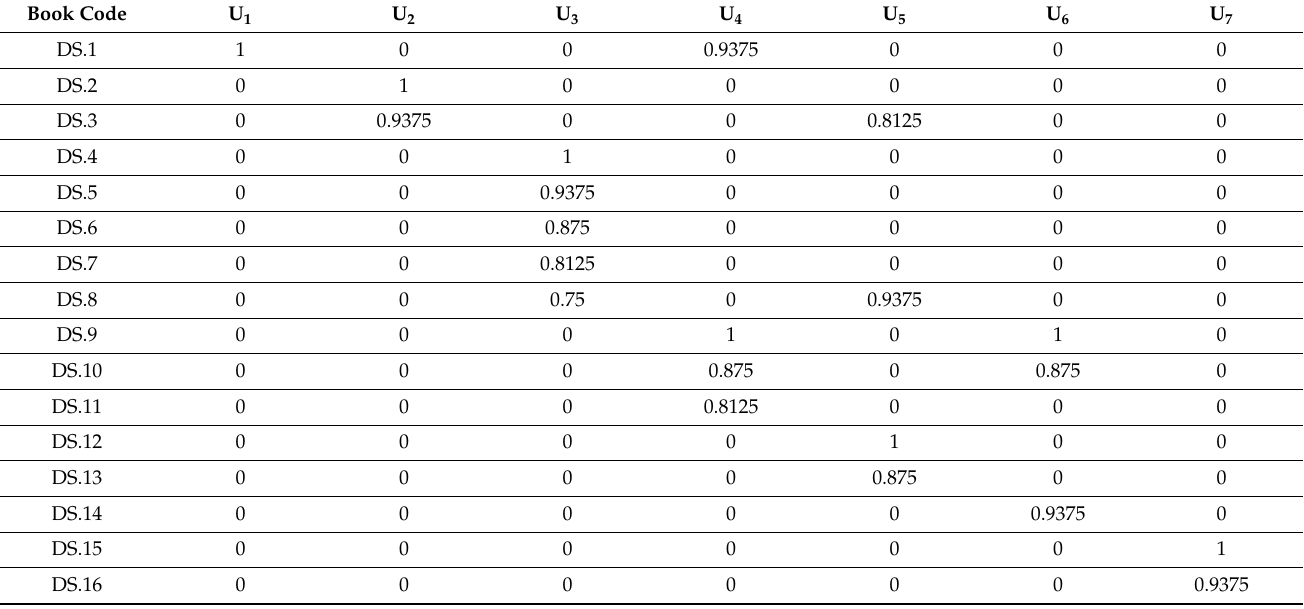
Table 4. Quantified Positional Score for books on Data